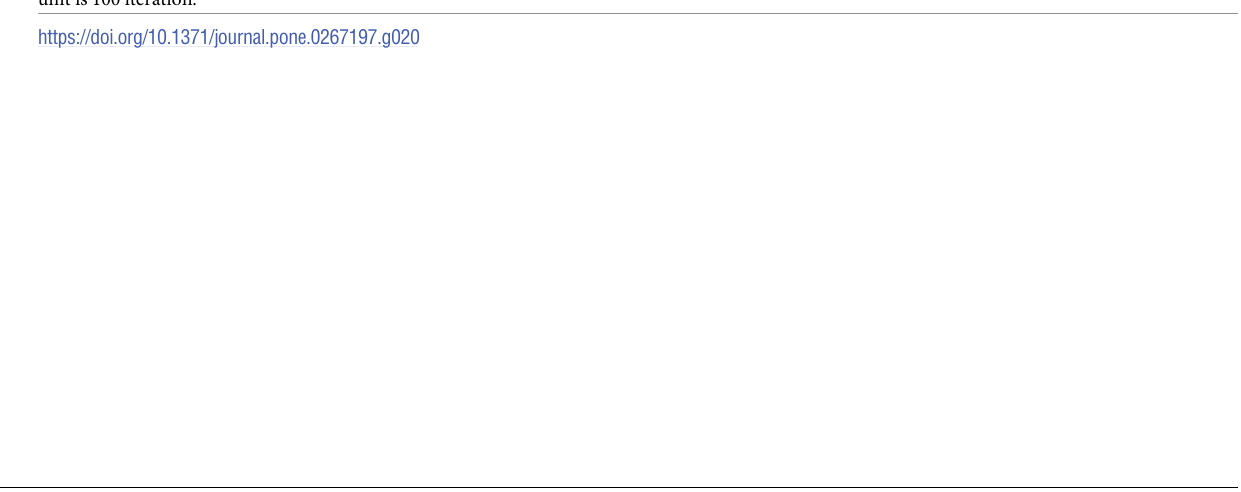
PLOS ONE | https://doi.org/10.1371/journal.pone.0267197 May 2, 2022 21 /